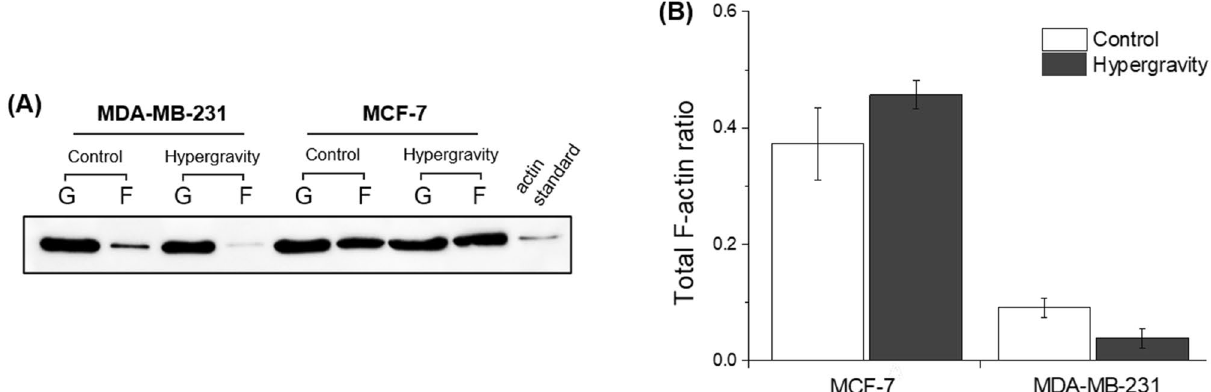
Figure 3. Western blot analysis of F-actin/G-actin. ( A ) Western blot showing the effects of hypergravity on the ratio of F-actin (expressed as F-)/total actin (F + G). ( B ) Graph of total F-actin ratio in static control group and hypergravity exposed group.